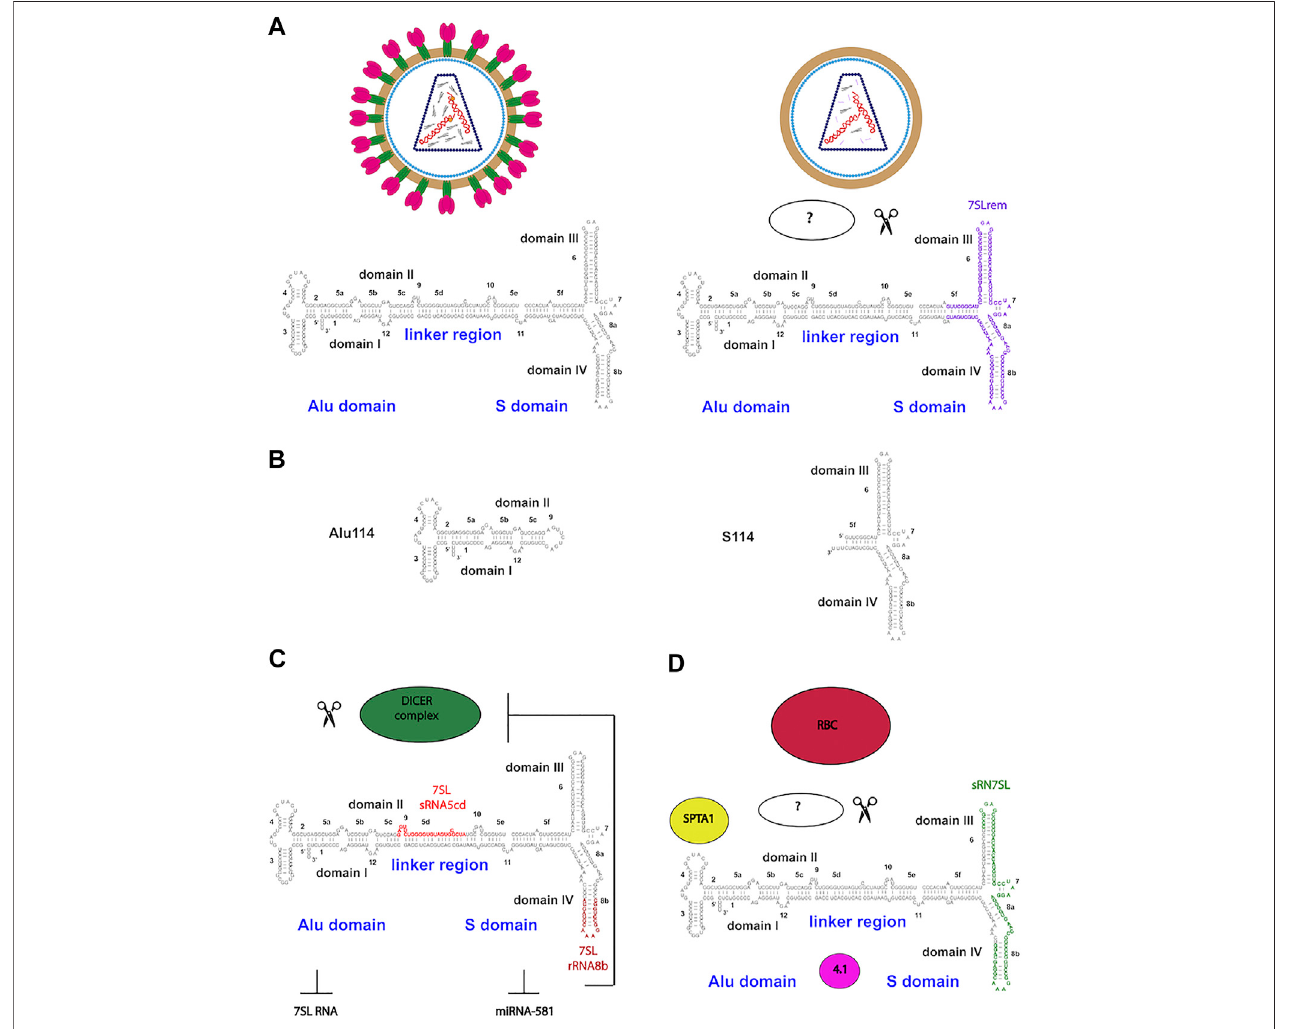
FIGURE 2 | Functional endonuclease processing of 7SL RNA in HIV-1 particles and RBCs (A) Trans -acting packaging determinants of 7SL RNA during HIV-1 packing.HIV-1matureandvirus-likeparticles(VLPs)retainedintact7SLRNAinNC-positiveVPLs(Gag-NCdomainisshownasorangedots).InNC-negativeVPLs,7SL RNA is retained mainly as an endoribonucleolytic fragment of 111 nt, named 7SL remnant (7SLrem) (B) The cis -acting determinants of 7SL packaging by HIV-1. Schematics of the Alu (Alu114) and the S domain (S114) derivatives capable of mediating packaging of 7SL RNA (C) 7SL RNA processing by Dicer in fragments sRNA5cd and sRNA8b which repress SRP complex formation and the expression of HBV surface antigen (HBsAg) (D) Enrichment for 7SL RNA and its fragment sRN7SL in an RBC RNP containing SPTA1 and protein 4.1.